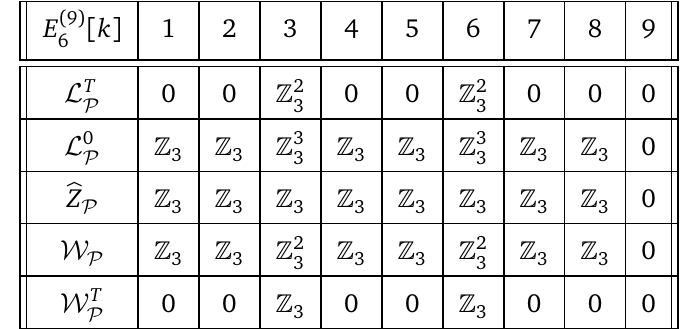
Table 9: Various contributions to the defect group for the untwisted punctures ( 9 ) [ k ] of type E N = ( 2,0 ) theory. The columns parametrize different values of k . P 6 6 The results can be extended beyond this table as they only depend on k ( mod 9 ) .